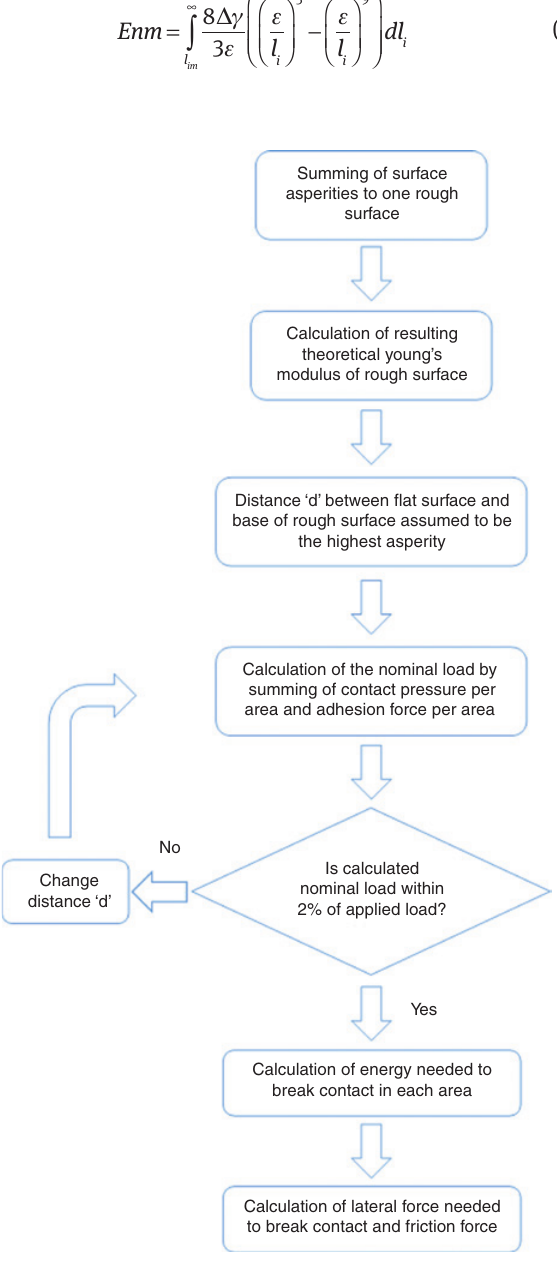
Figure 4: Block schematic of the friction simulation